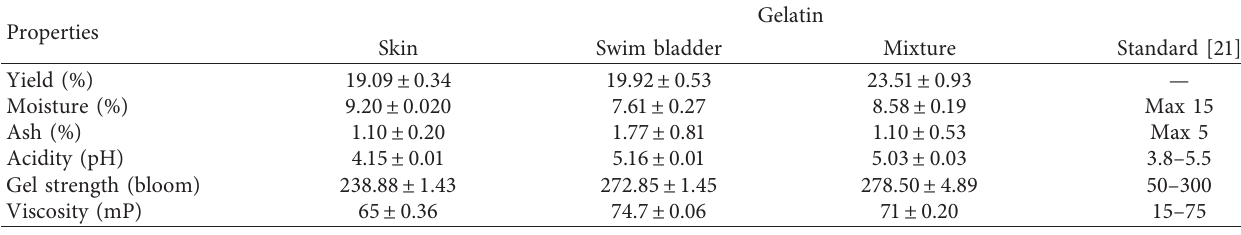
Table 2: Physicochemical properties of gelatin.